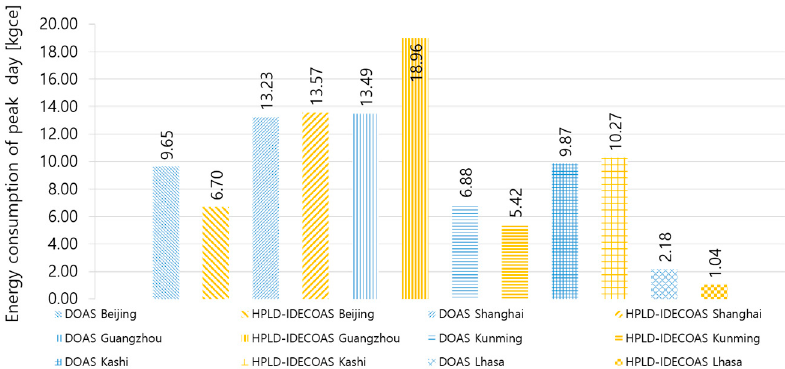
Figure 10. Comparison of cooling load of each selected city.